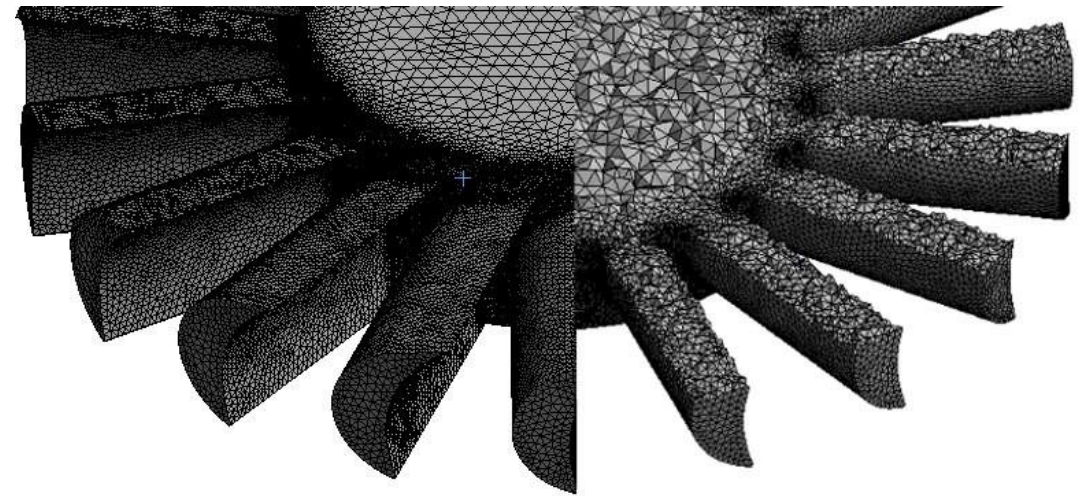
Figure 40. Surface ( left ) and section view ( right ) of the rotor mesh illustrates the elements ’ size and distribution.